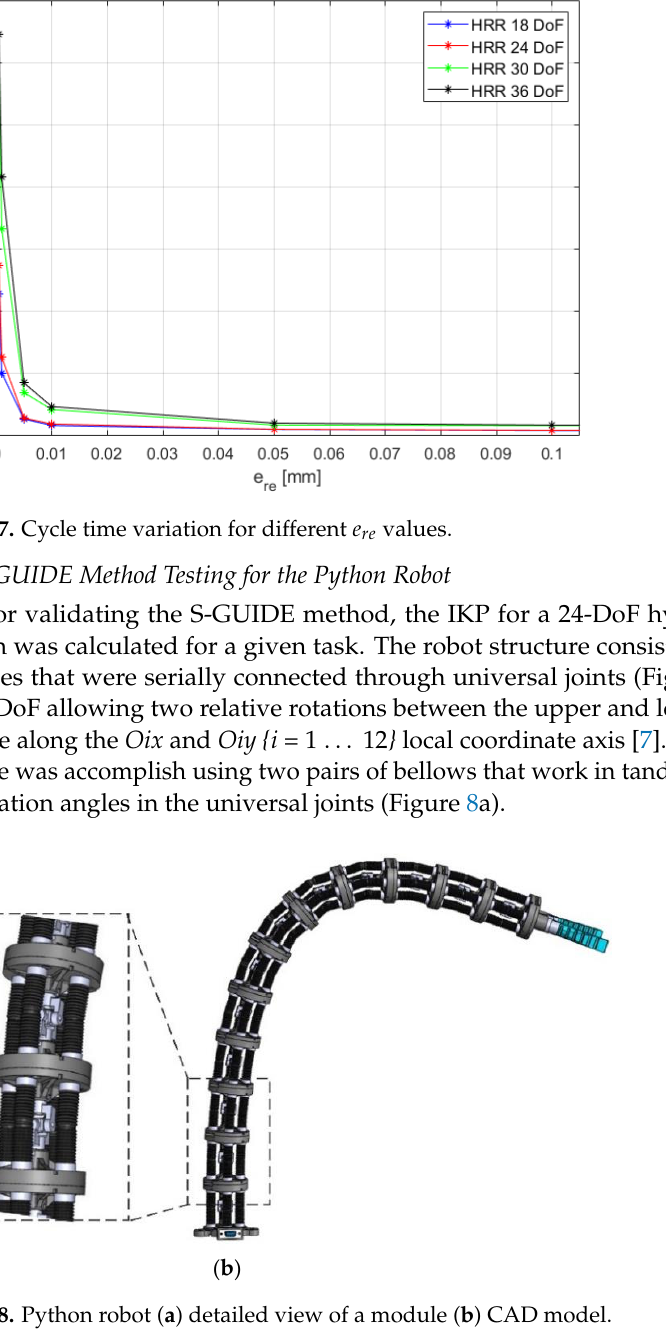
Figure 8. Python robot (a) detailed view of a module (b) CAD model.